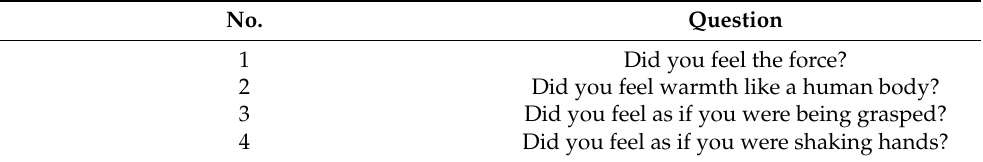
Figure 12. The seven experimental glove patterns. Table 3. Questions for the sensory